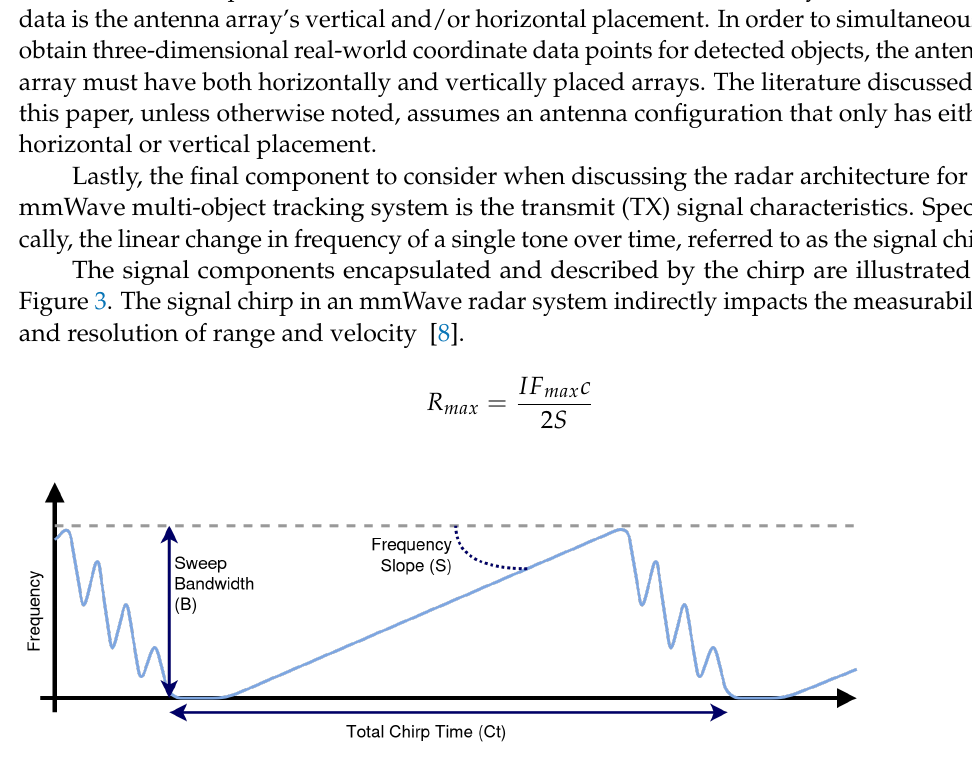
Figure 3. Signal chirp components. An example chirp, where the frequency is represented over time to ultimately demonstrate sweep bandwidth and frequency